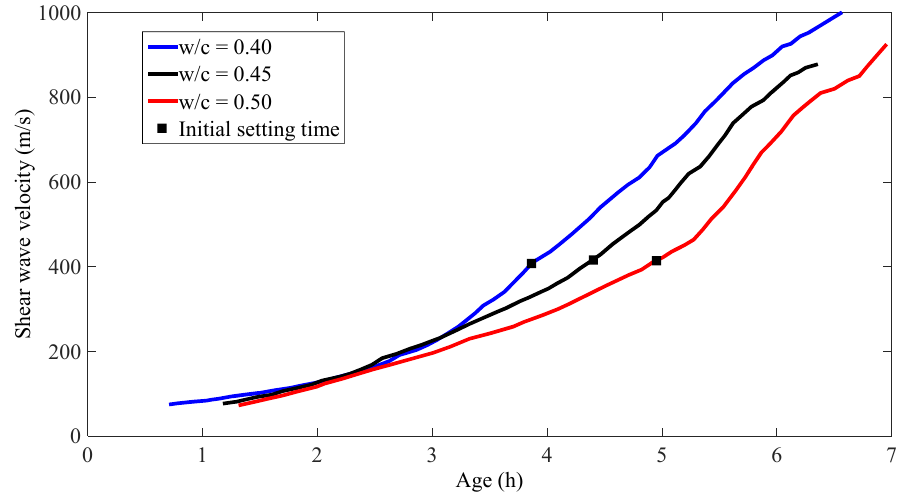
Figure 3. Shear wave velocities in different w/c mortar samples.